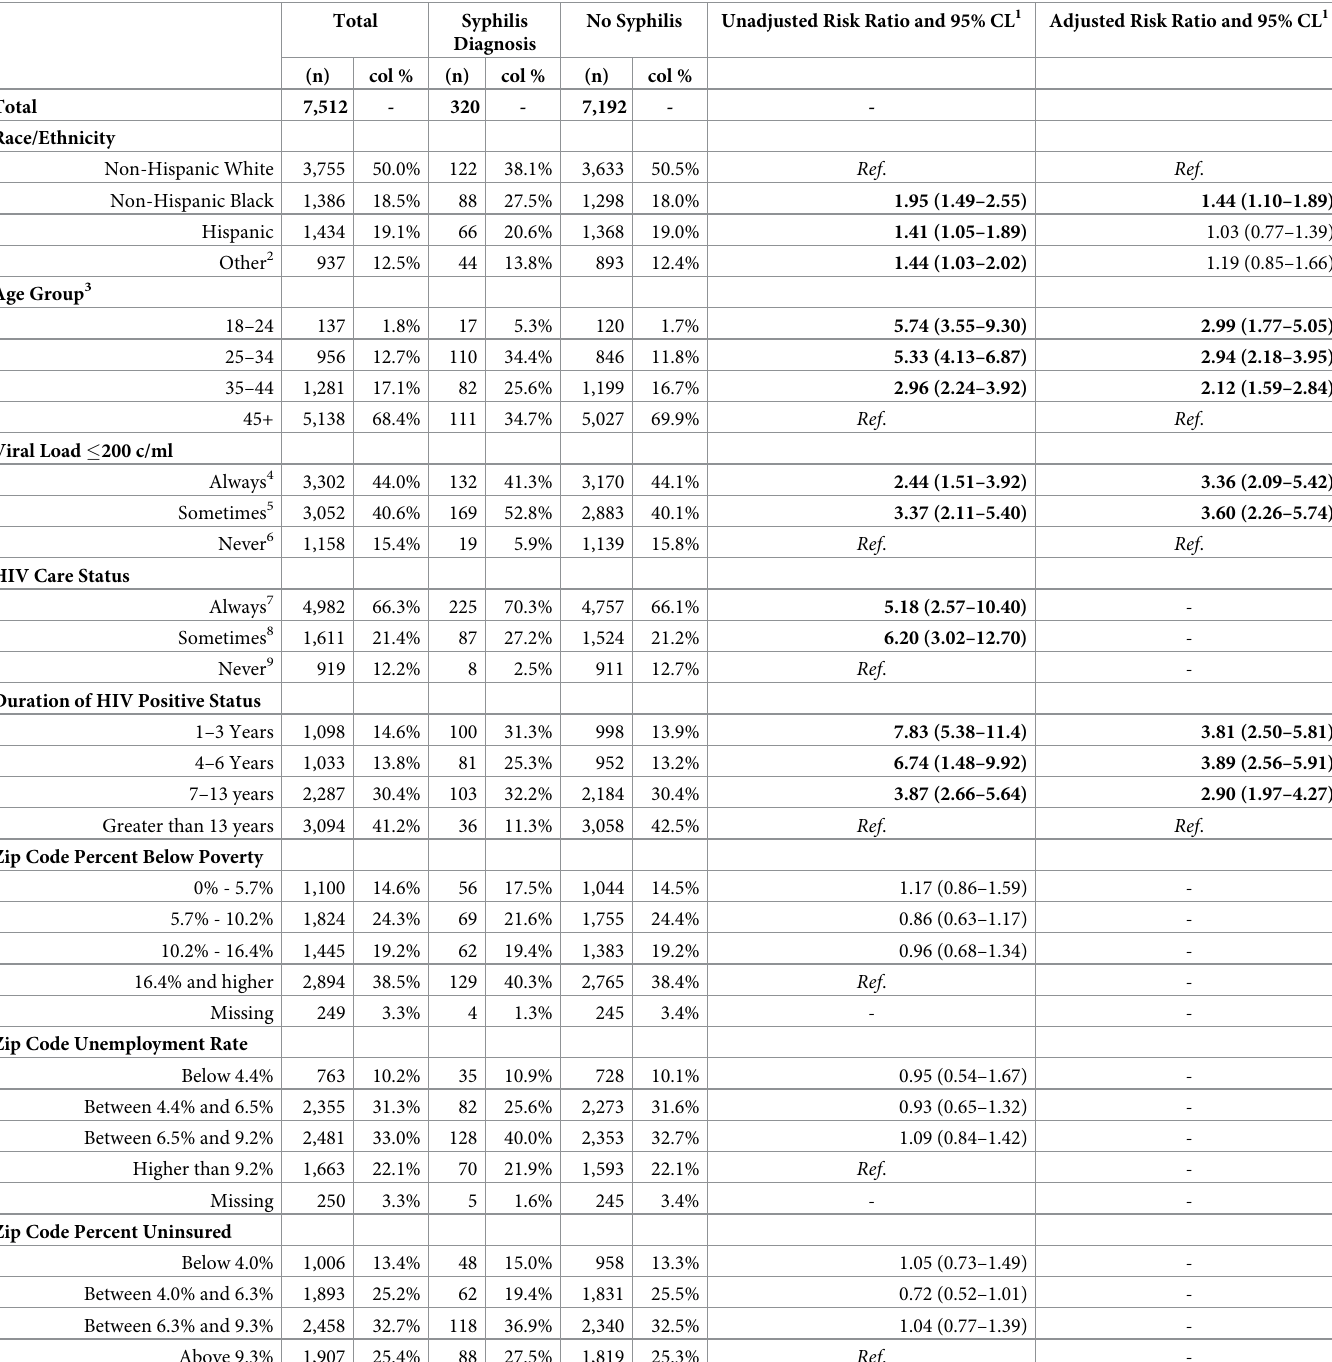
Table 1. Descriptive analysis for cohort of adult males with a history of male-to-male sexual contact living with diagnosed HIV, and syphilis diagnosis status: New York state excluding New York city,